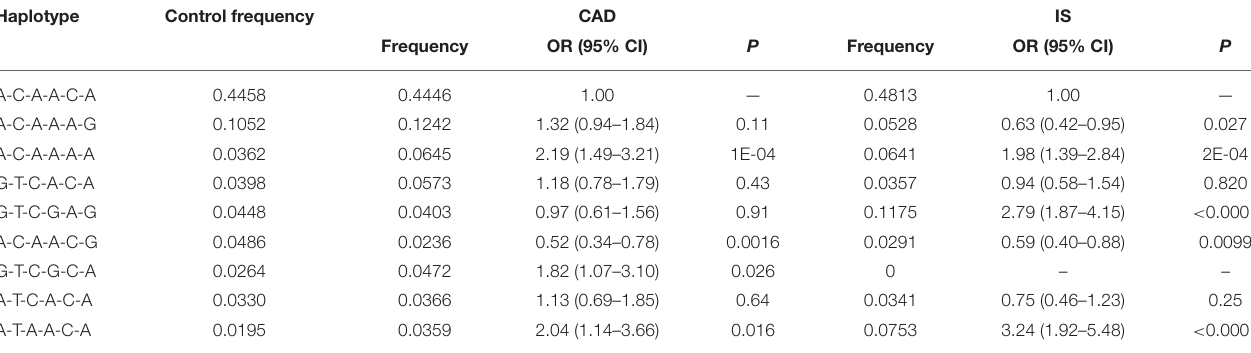
TABLE 4 | Haplotype frequencies of the six SYTL3 - SLC22A3 SNPs and the risk of CAD and IS.